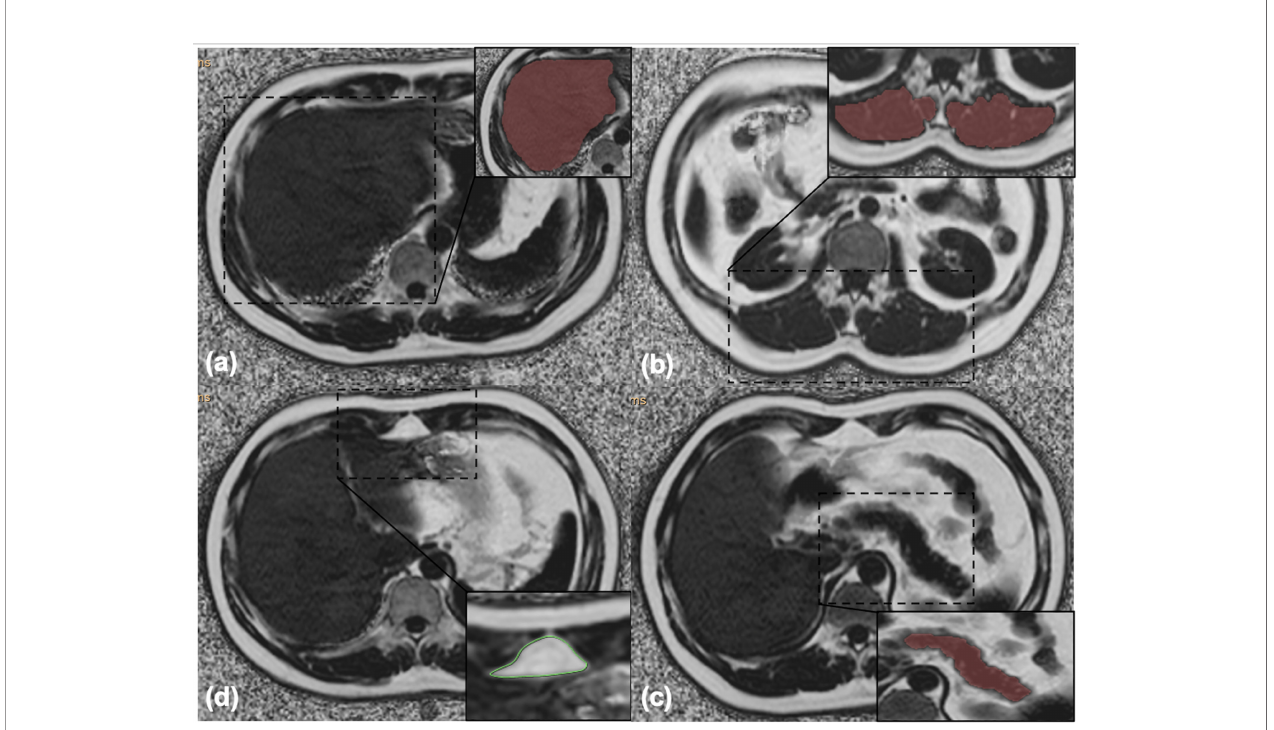
FIGURE 1 | (A) Liver segmentation: the whole hepatic fat fraction was calculated using the 3D semiautomatic segmentation method. (B) Muscle segmentation: the arithmetic mean fat fraction of bilateral paraspinal muscles (including erector spinae and multi fi dus muscles) in the scanning range was calculated as the intramuscular fat fraction using the 3D semiautomatic segmentation method. (C) Pancreas segmentation: the whole pancreatic fat fraction was calculated using the 3D semiautomatic segmentation method. (D) Preperitoneal adipose tissue measurement: the area and the fat fraction of preperitoneal adipose tissue were measured using spline contour region of interest (ROI)